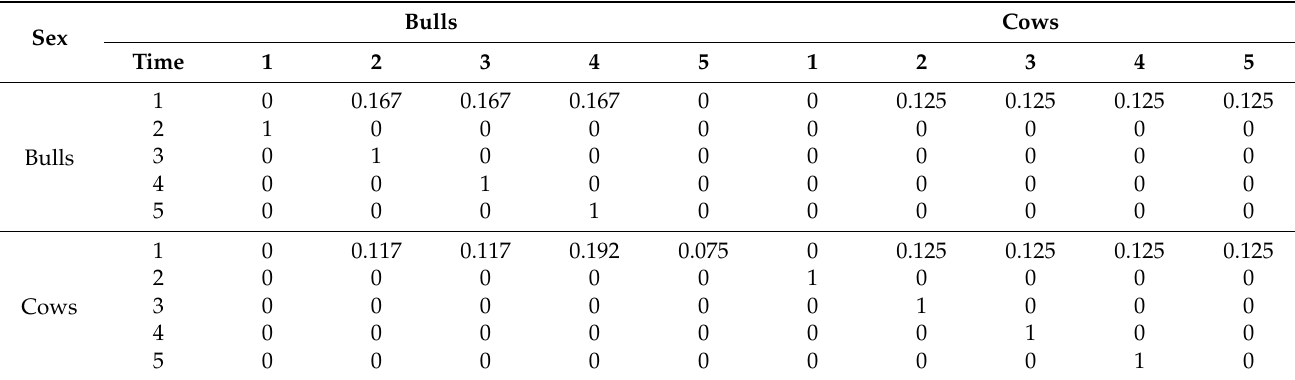
1 The allele flow matrix, where p ij represents the proportion of alleles in class i at time t that come from class j at time t − 1. This matrix describes the source of all alleles in each age class